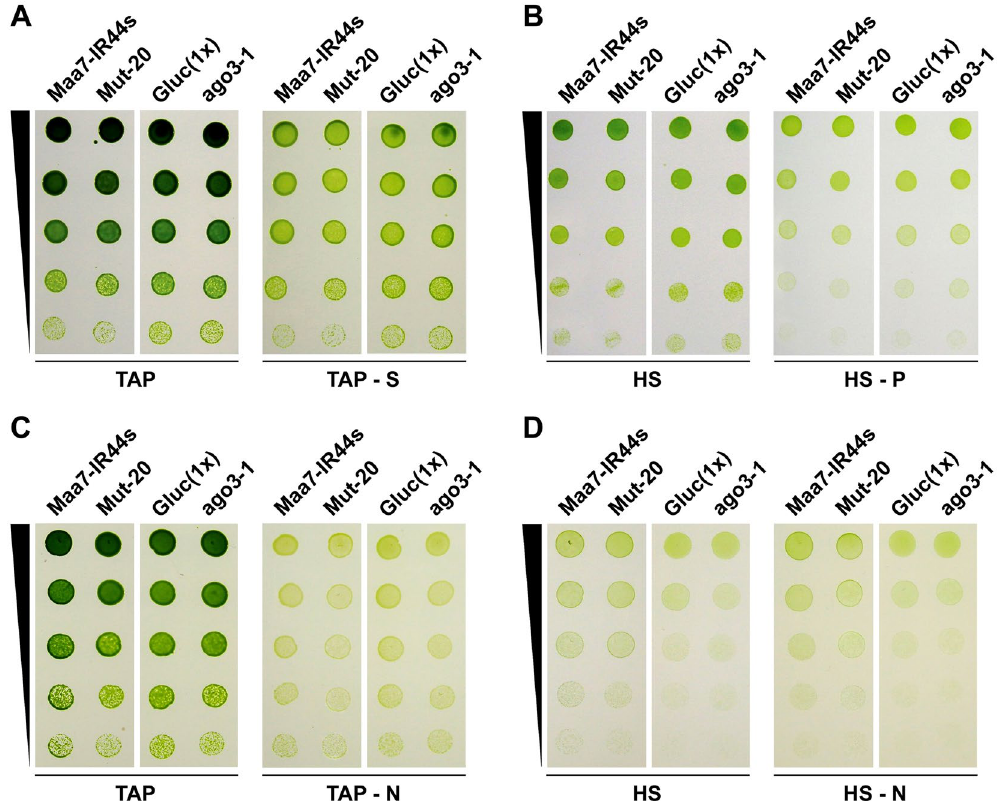
Figure 4. Growth and survival of Chlamydomonas cells subjected to various nutritional deprivation conditions. Cells grown to logarithmic phase in TAP medium were serially diluted in water, 5 μ l-aliquots spotted on plates of the appropriate media and incubated for 7 to 15 days under continuous illumination. Maa7- IR44s, CC-124 strain containing a transgene expressing FLAG-tagged AGO3; Mut-20, TSN1 deletion mutant,